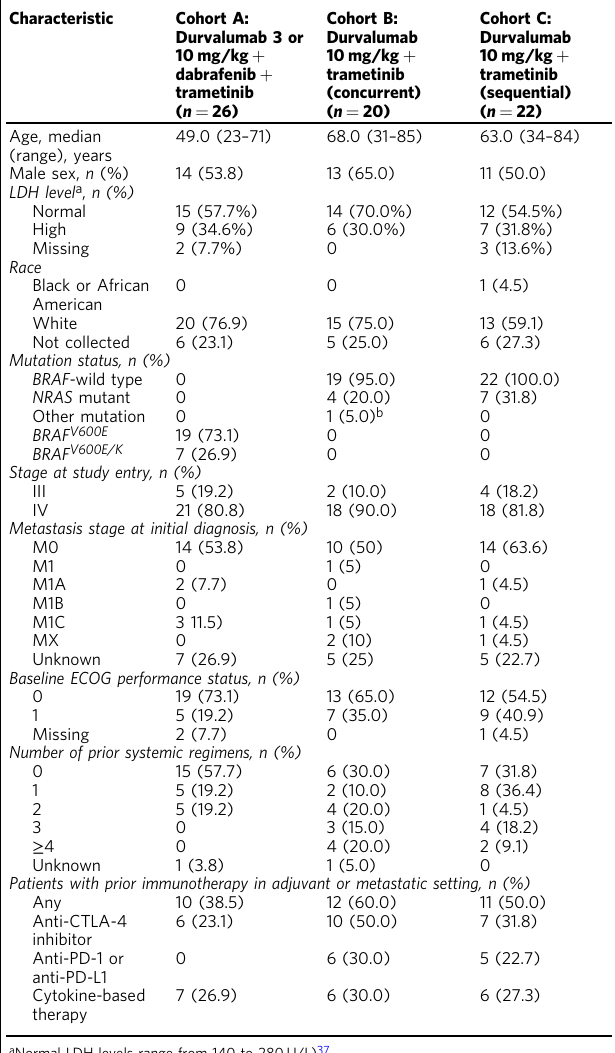
Table 1 Patient demographics at baseline (as-treated